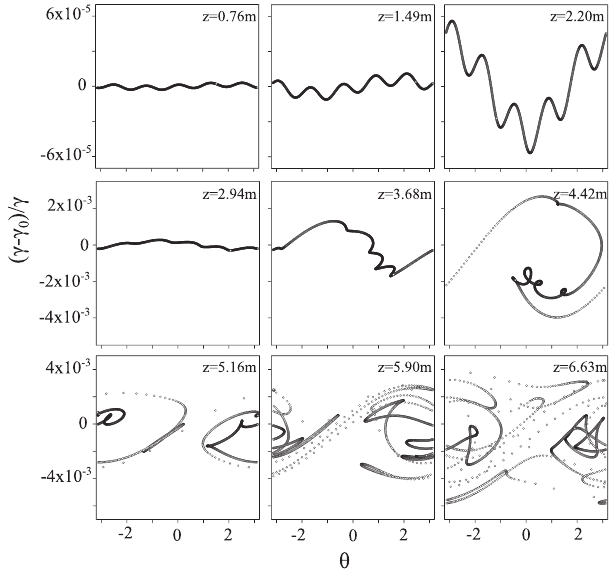
=L as FIG. 4. Electron longitudinal phase space for m=n ¼ 5 and g 1 g 2 different values of the coordinate z along the